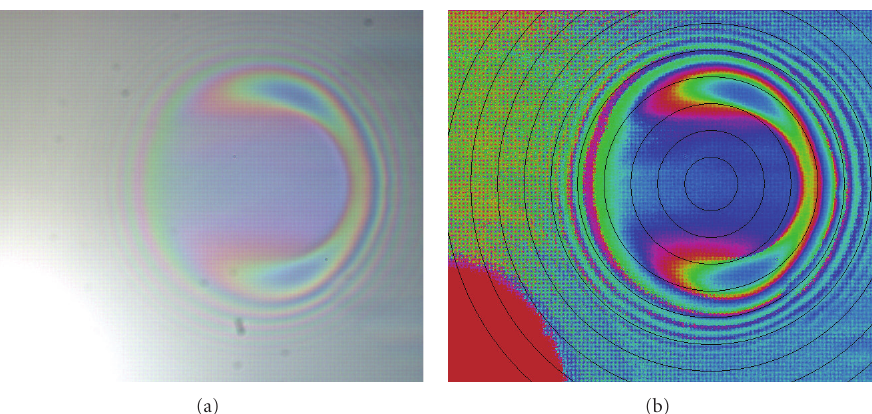
Figure 7: White light interferogram of an EHL point contact as recorded by the camera (a) and image with enhanced colours and circles displayed to facilitate the selection of the central point (b).